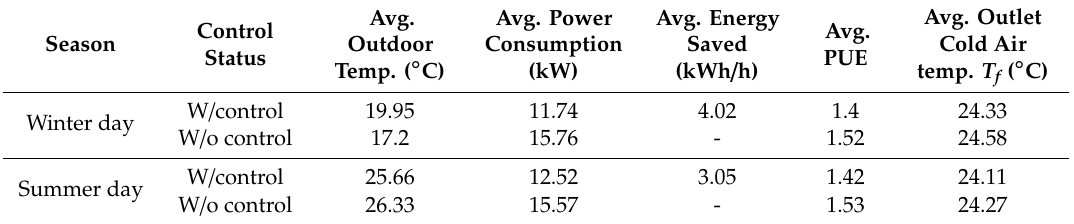
Table 2. Comparison of energy saving performance with and without